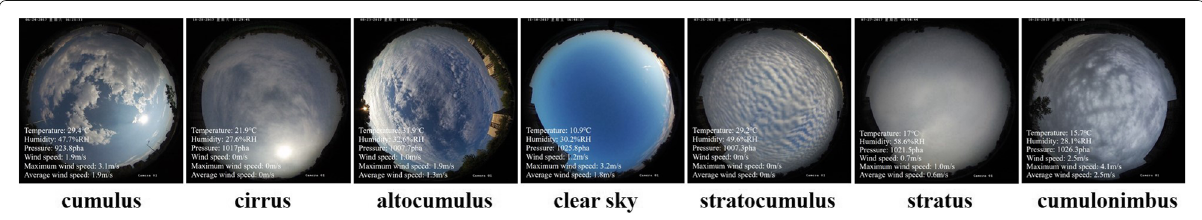
training image subtracts the mean RGB values computed on training set from each pixel.